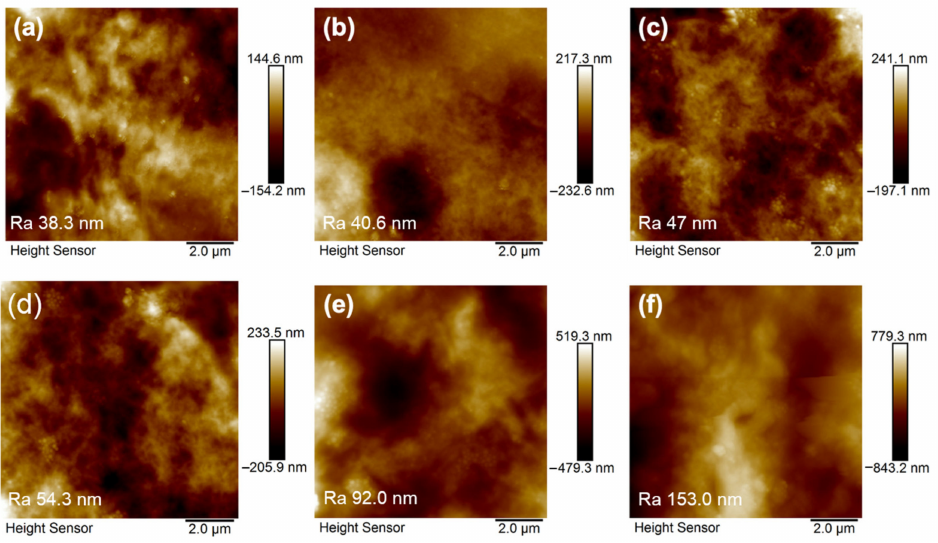
Figure 4. AFM images of starch film ( a ) and SL composite films ( b – f ) containing 1%, 2%, 3%, 4%, and 5% LNPs.